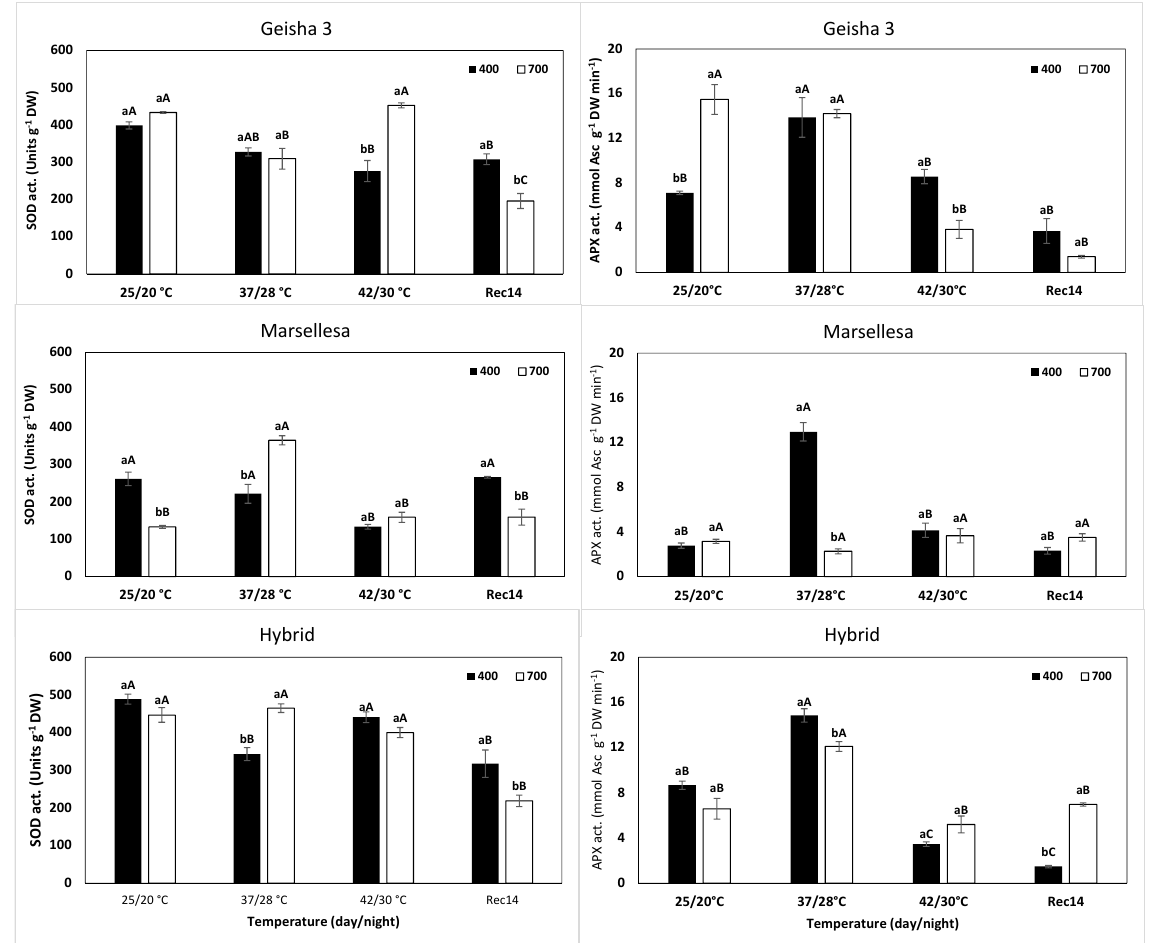
Figure 1. Changes in leaf cellular activities of superoxide dismutase (SOD) and ascorbate peroxidase (APX) enzymes in C. arabica cv. Geisha 3, cv. Marsellesa and their Hybrid (Geisha 3 × Marsellesa) plants grown under 400 or 700 µ LCO 2 L − 1 at control (25/20 ◦ C, day/night), submitted to supra- optimal temperatures (37/28 ◦ C, 42/30 ◦ C), and after 14 days of recovery (Rec14). For each enzyme, the mean values ± SE ( n = 3 plants) followed by different letters express significant differences between CO 2 treatments for each temperature, separately for each genotype (a, b), or between temperatures for the same CO 2 treatment (A, B, C), always separately for each genotype, where a > b and A > B >